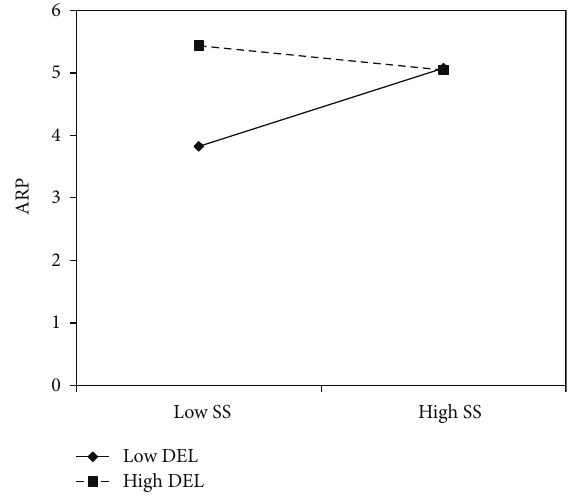
F 3: Depression and elation lability moderated the effect of sensation seeking on alcohol-related problems among college students.